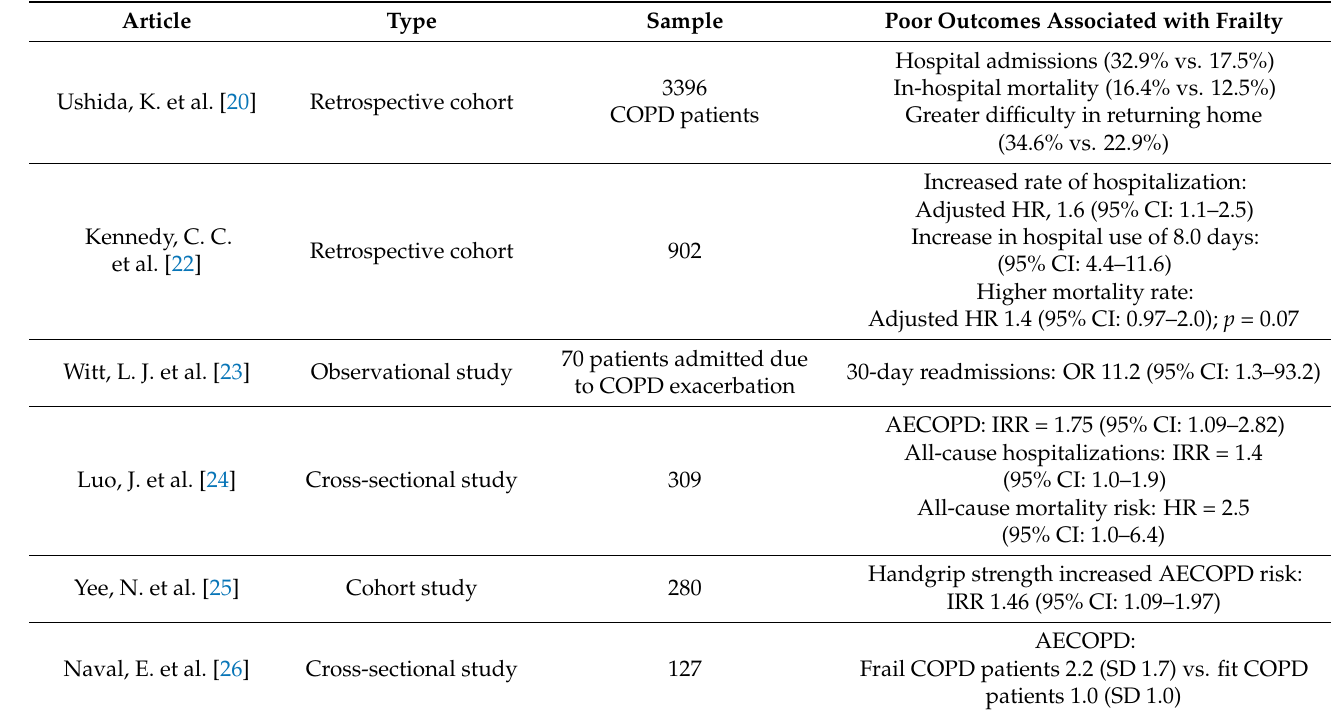
Table 2. Relationship between health outcomes and frailty in COPD